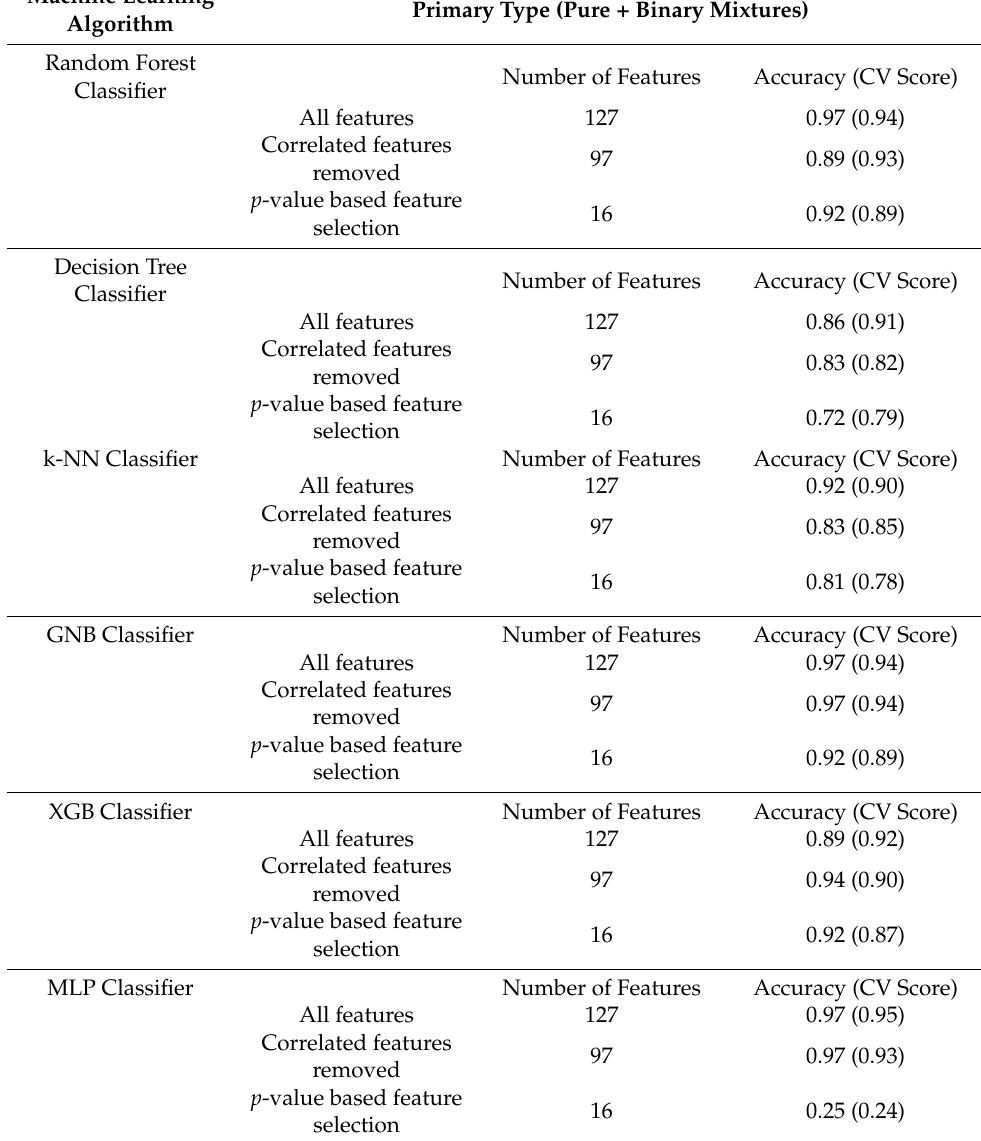
Table 6. Comparison of ML algorithms for prediction of pure and mixed primary biomass types from py-MBMS spectral intensities after RUV correction of the spectra.